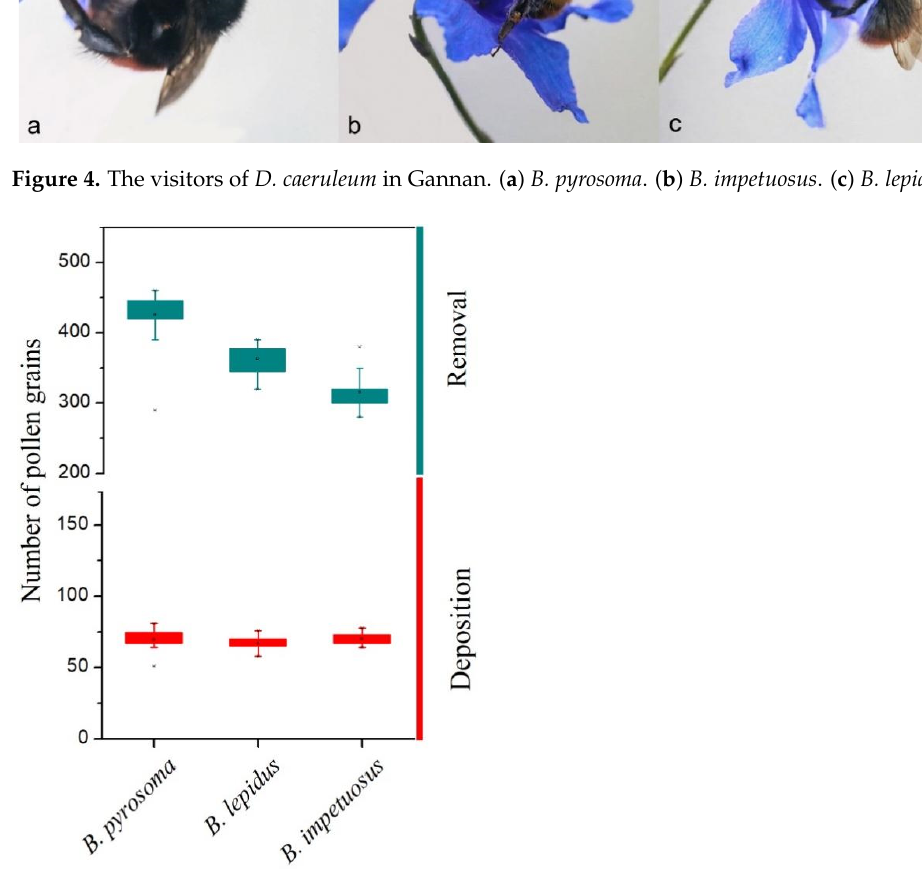
Figure 5. Mean ( ± SD) amount of pollen grains deposited on stigmas and pollen removed of visitors on the D. caeruleum . Boxplots represent the number of pollen grains deposition and amount of pollen removed (red for pollen deposition and dark cyan for pollen removed by visitors), showing medians, quartiles, interquartile ranges, and outliers. Table 1. The number of visit times by visitors to flowers of D. caeruleum with different treatments in different flowering phases.